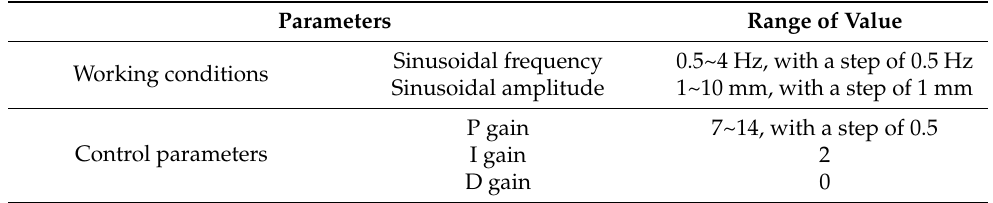
Table 2. Collection range of simulation learning